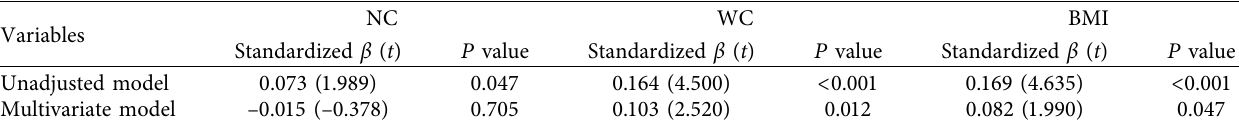
Figure 3: Free triiodothyronine (FT3) levels according to (a) neck circumference (NC) quartiles, (b) waist circumference (WC) quartiles, and (c) body mass index (BMI) quartiles. Table 2: Linear regression analysis for the associations of FT3 with NC, WC, and